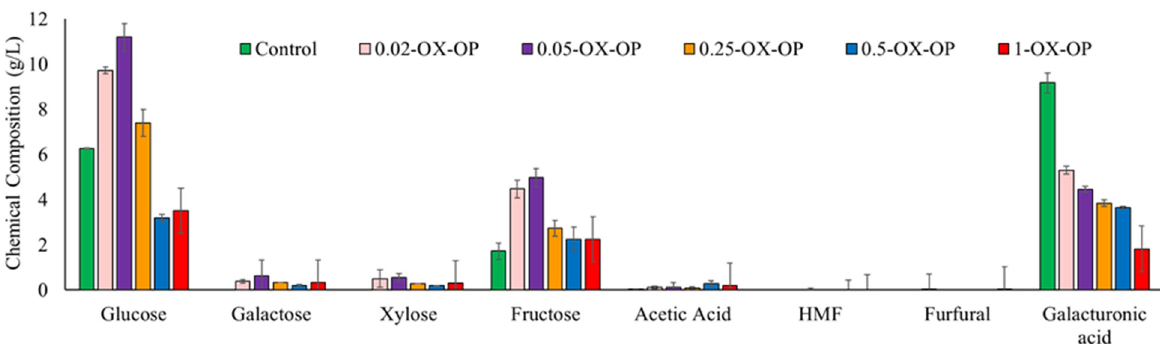
Figure 2. Sugar content in control and after 1 h of oxidation pretreatment by different concentration of oxidative agents.